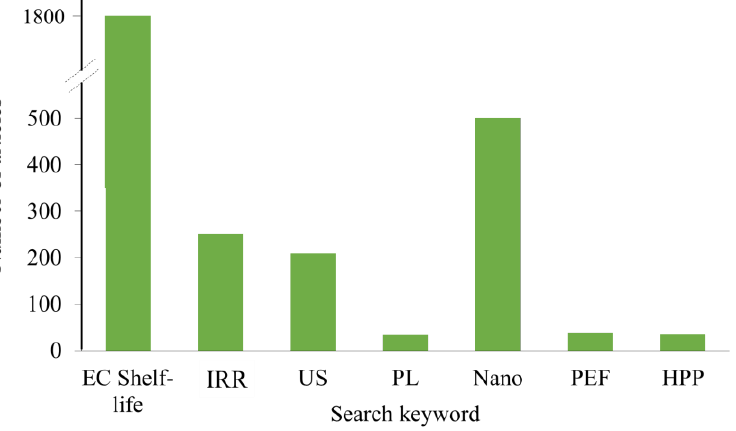
Figure 2. Number of scientific articles found in Science direct in the period from 2017 to 2022.